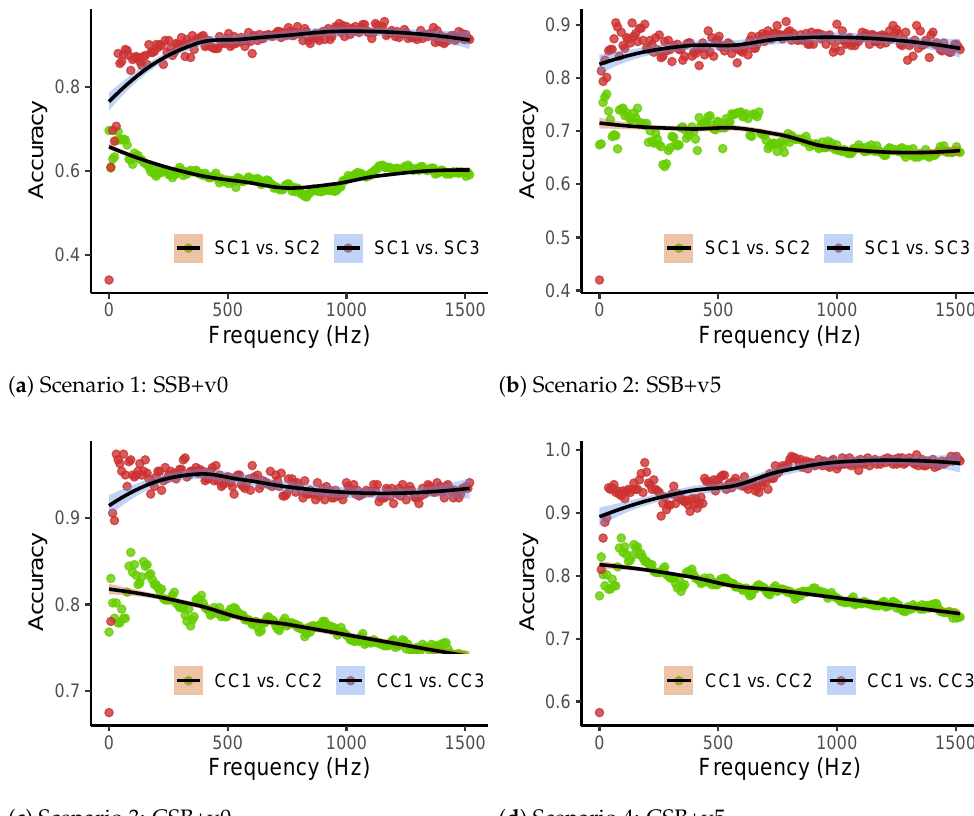
Figure 12. Classification accuracy with different frequency